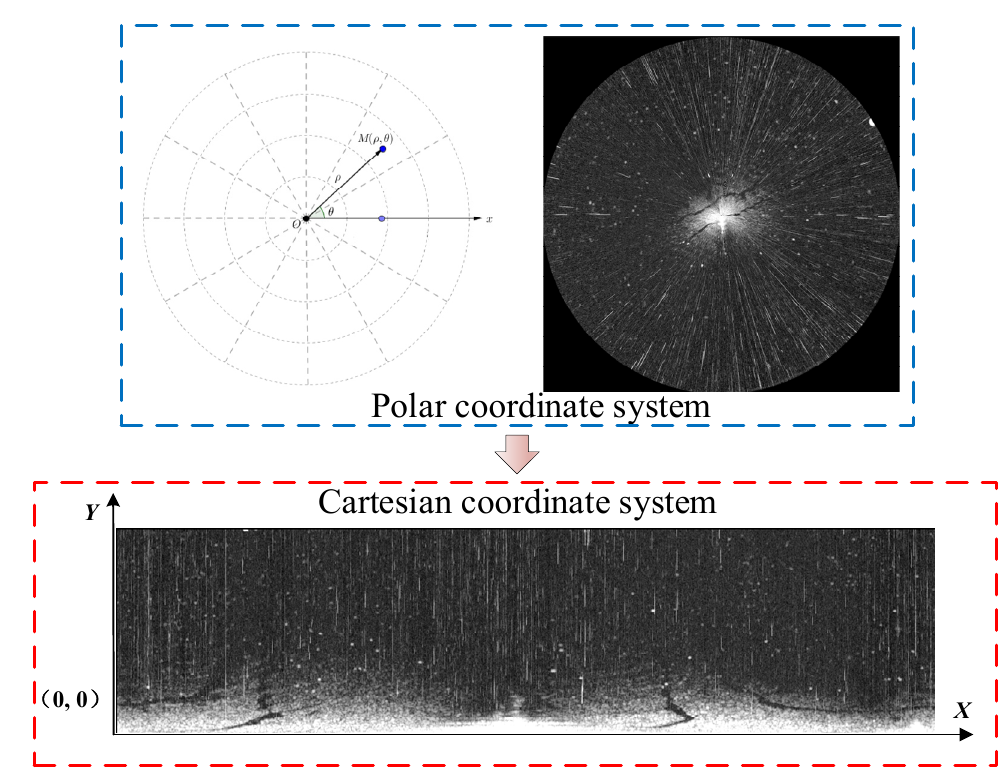
Figure 2. The transformation of the coordinate